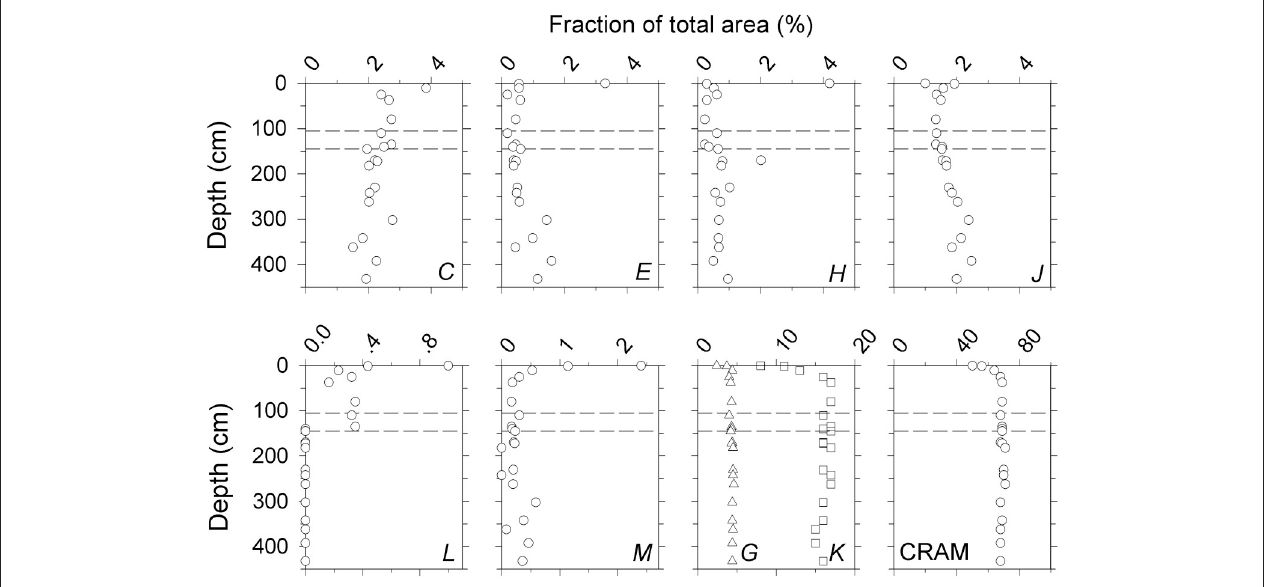
FIGURE 5 | Depth variability in the fraction of total area attributed to peaks ( C – M ) and CRAM obtained on the 400 MHz spectrometer. Bands G and K were considered to be components of CRAM. Depth profiles of bands N , O, and P are given in Figure 3 . Analogous profiles obtained on the 600 MHz spectrometer are shown in Supplementary Figure 2. Dashed lines indicate the upper and lower boundaries of the sulfate-methane transition zone (SMTZ, 125 ± 10cm; see section Group-2 Resonances).